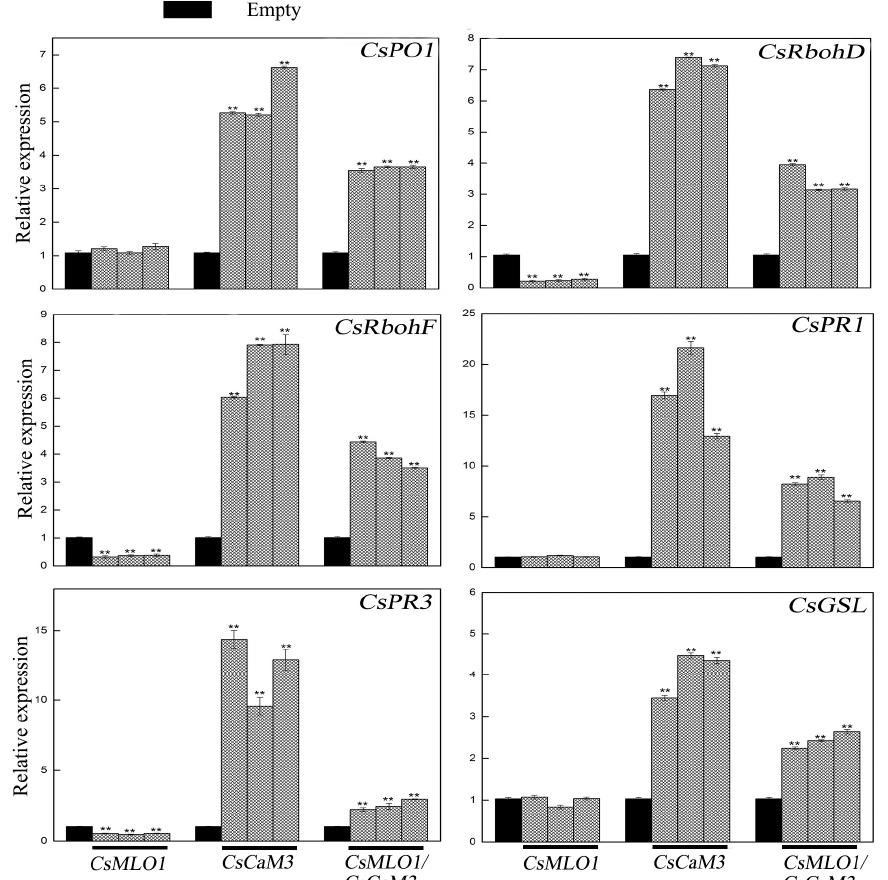
Figure 9. Expression analysis of the CsRbohD (cucumber NADPH oxidase homolog D), CsRbohF (cucumber NADPH oxidase homolog F), CsPO1 (cucumber ascorbate peroxidase), CsPR1 (cucumber defense marker gene), CsPR3 (cucumber defense marker gene), and CsGSL (cucumber callose deposition-related gene) genes were determined by RT-qPCR in cucumber cotyledons 5 d after agroexpression. Data are the means ± standard deviations from three biological experiments, and each column represents a sample containing three cucumber cotyledons from different plants. Expression analysis of candidate genes using the 2 −ΔΔ Ct method. The asterisks indicate a significant difference (Student’s t test, ** P < 0.01).